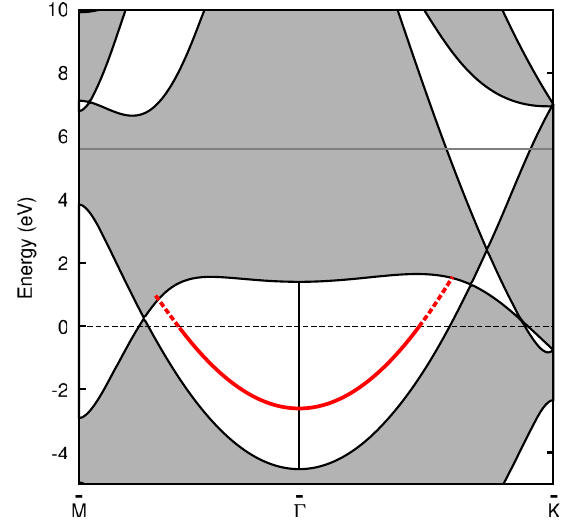
FIG. 3. Calculated Be(0001) bulk and surface electronic states in the surface Brillouin zone: Projected bulk states (grey shading) and the surface state below (solid red line) and above (dashed red line) the Fermi level (thin dashed line). The DFT evaluated vacuum level at ϕ ð 0001 Þ ¼ 5 . 61 eV is indicated by a thin solid